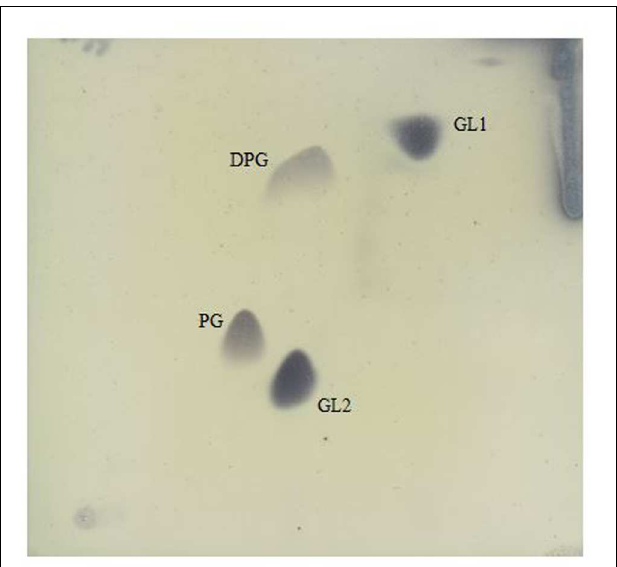
FIGURE 5 | Polar lipids of isolate 17-2-E-8 as separated by two dimensional silica gel thin layer chromatography. The first direction is developed in chloroform:methanol:water (65:25:4, v/v/v), and the second in chloroform:methanol:aceticacid:water (80:12:15:4, v/v/v/v). Four spots were detected reflecting glycolipids (GL1 and GL2), diphosphatidylglycerol (DPG), and phosphatidylglycerol (PG) fractions.